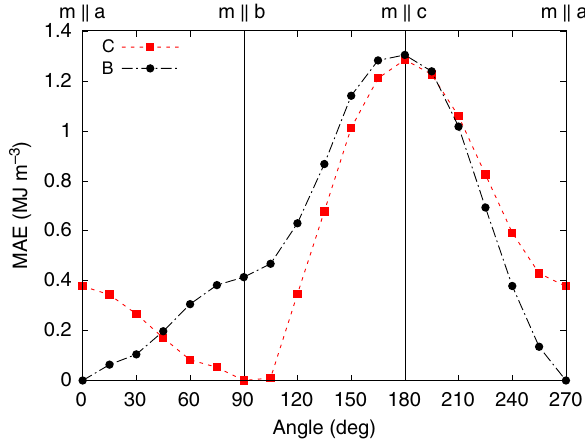
Fig. 4 Magnetic anisotropy in BiMO. Energy as a function of the orientation of the magnetization for the C (dashed, squares) and B (dashed – dotted, circles) ground states of BiMO. The easy axis is b for the C state, and a for the B